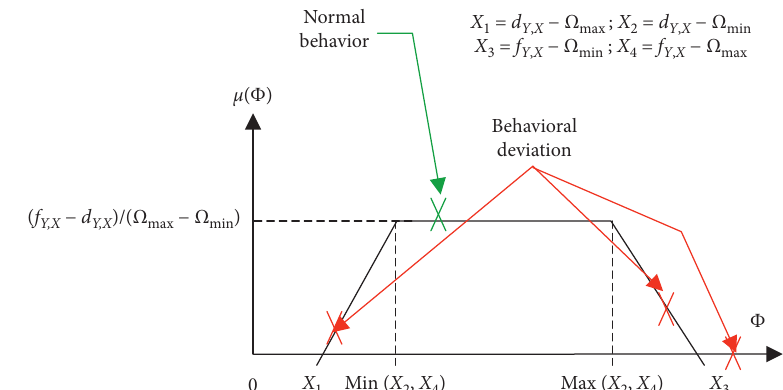
Figure 7: Possibility function for an interval constraint with X